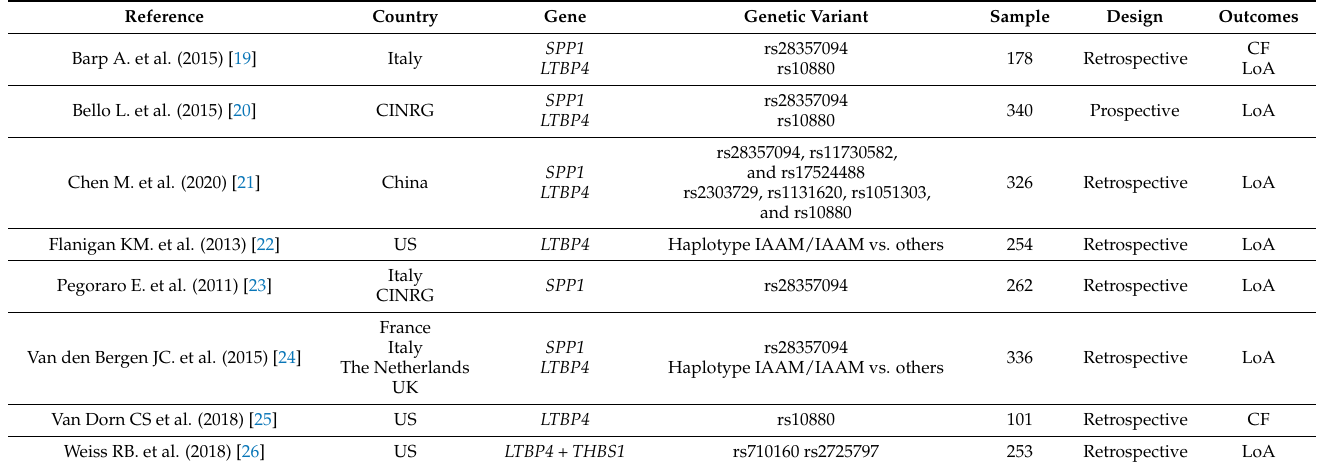
Table 1. Characteristics of the included